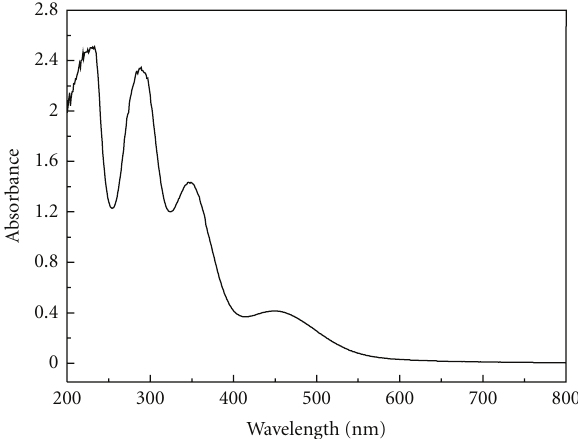
Figure 1: The UV-Vis spectrum of the reaction system.